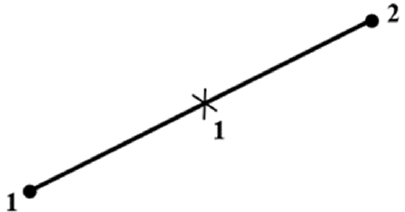
Figure 4. Linear 3D truss elements with two nodes (T3D2).